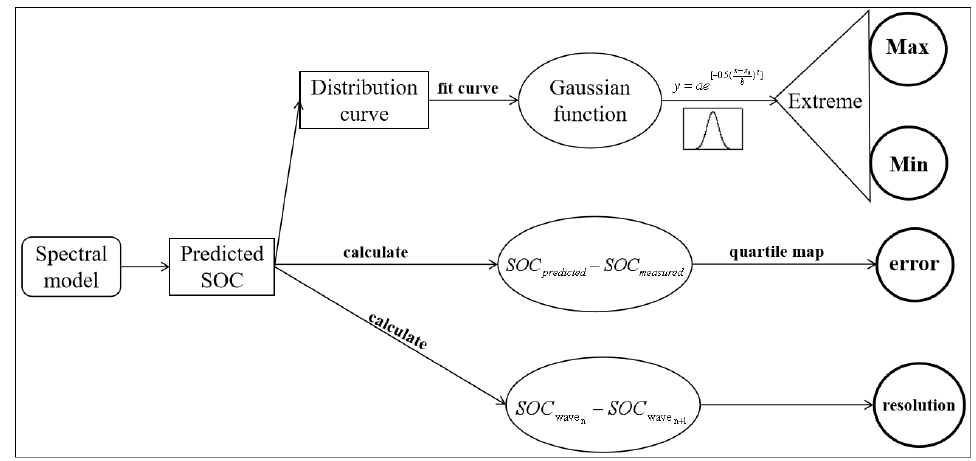
Figure 2. The flow chart for calculating the proposed parameters.